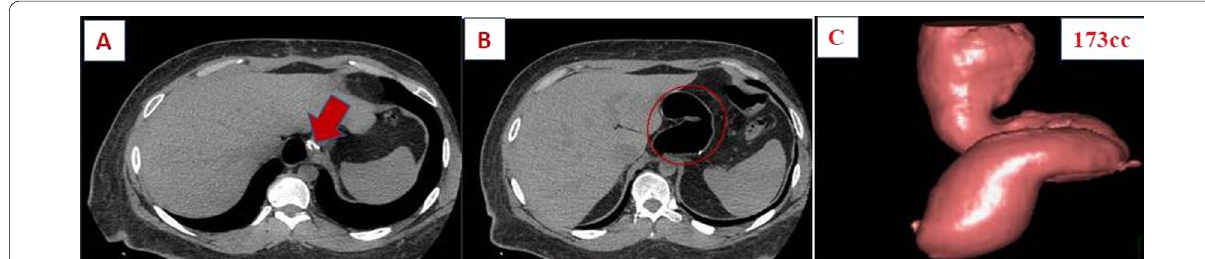
Fig. 7 A 30‑year‑old obese male (BMI 45.2) with postoperative gastric volume is 173 cc. Preoperative weight and 1‑year postoperative = weight were 120 kg and 72 kg, respectively. Weight reduction percentage is 40%, and 1‑year postoperative BMI is 27% of loss from the excess weight 84.2%. Although the postoperative gastric volume is high, the patient weight loss after 1 year is high. A, B CT abdomen are showing = staples (arrow) and gastric pouch (circle). C 3D CT gastric volumetry showing gastric volume of 173 cc